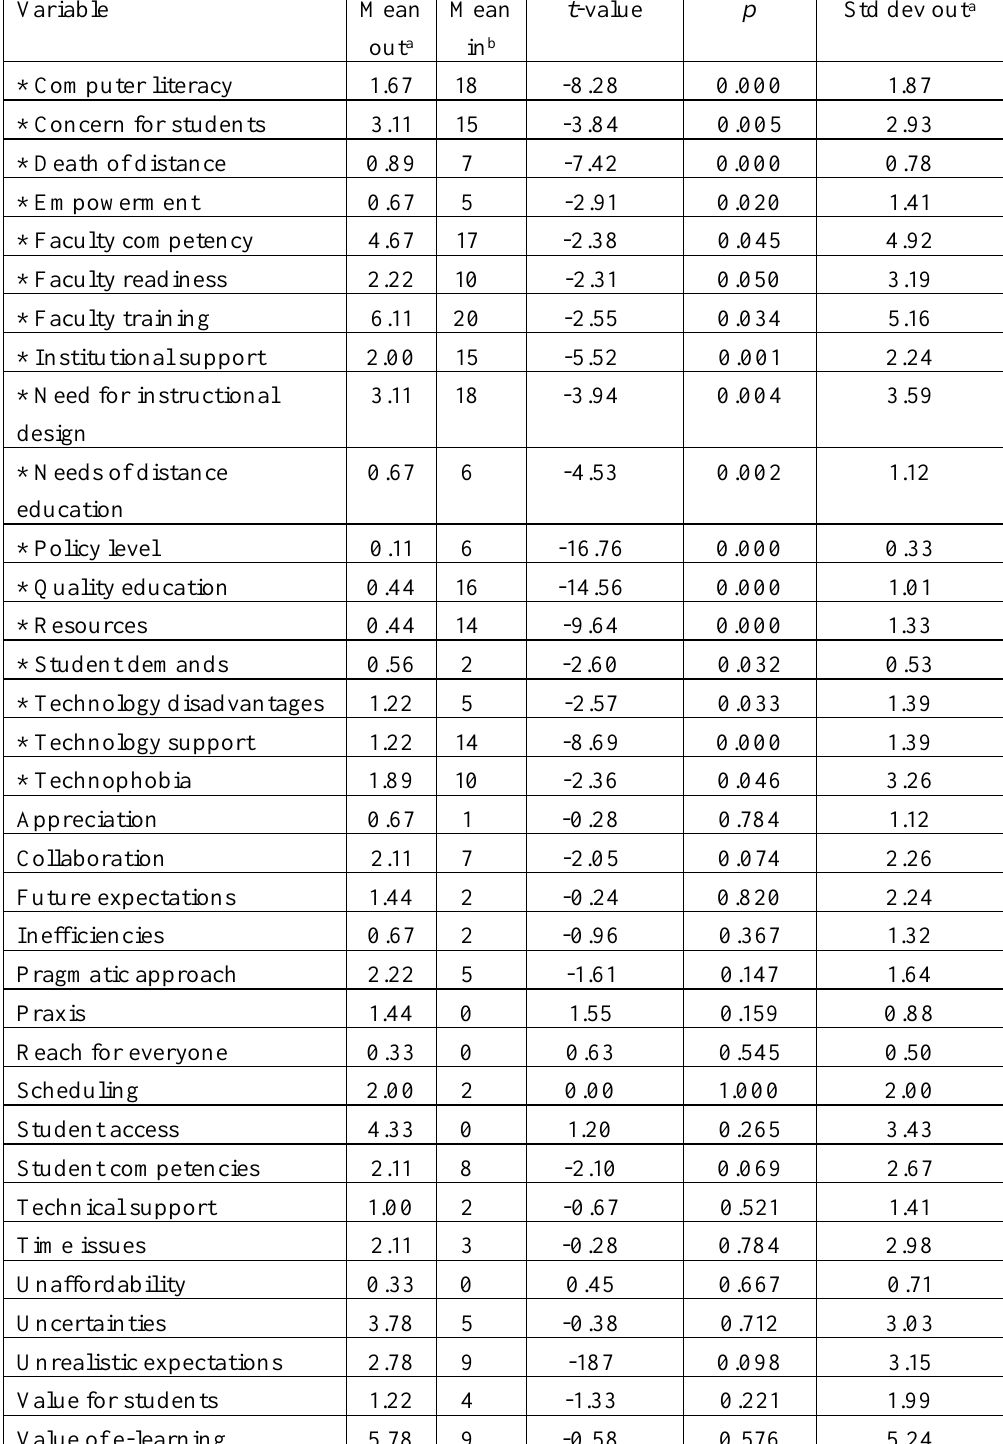
Table 2 Calculation of Significant Differences between Faculty Perceptions (Looking Out) and Observations of e-Learning Manager (Looking In) Variable